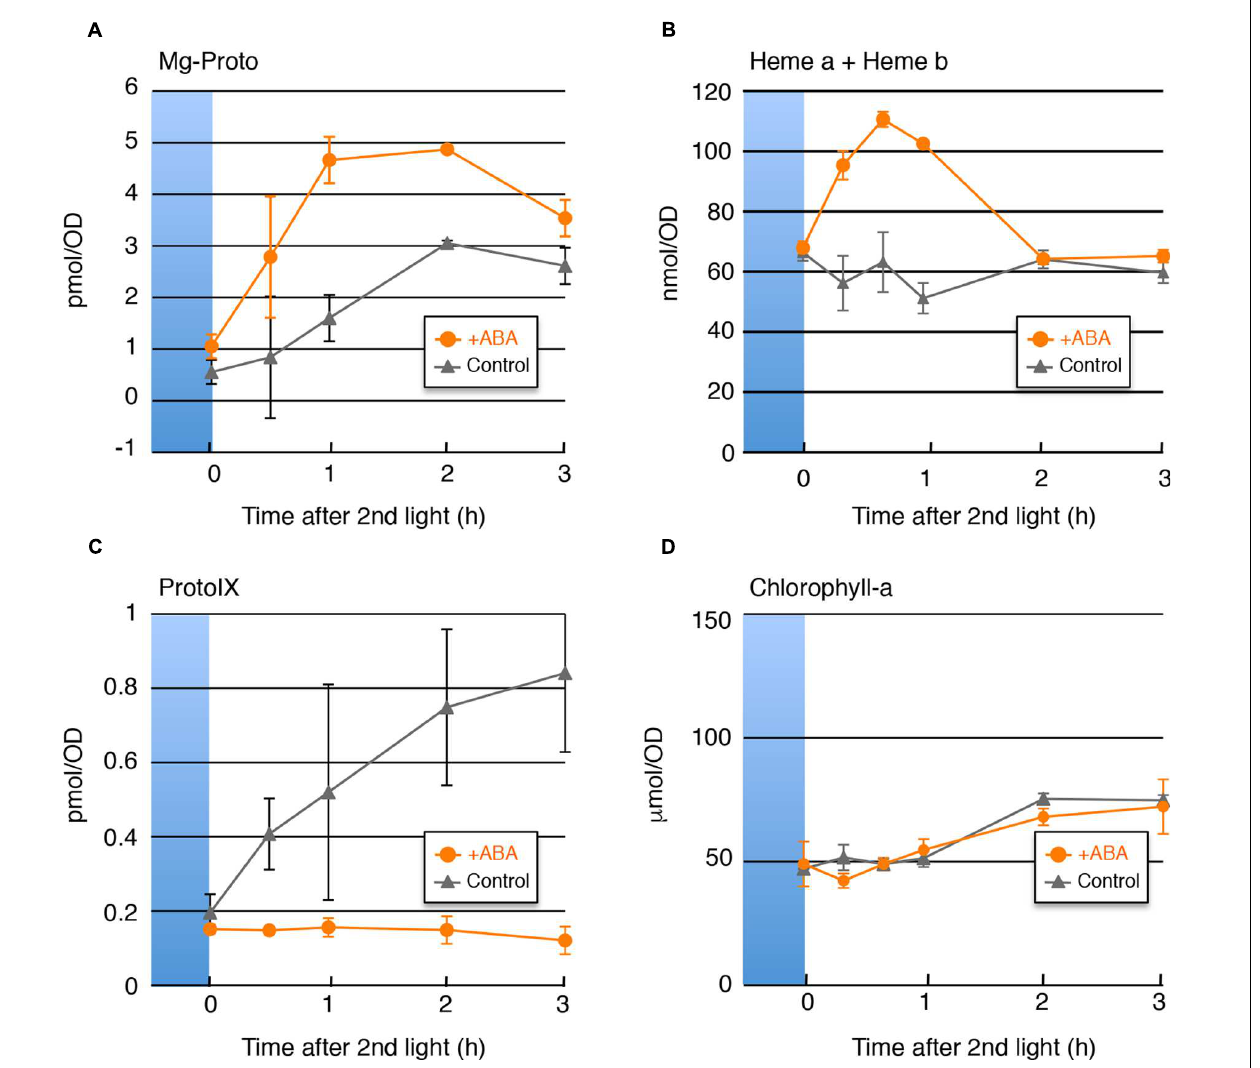
FIGURE 2 | Cellular Contents of Mg-ProtoIX, Heme, ProtoIX, and Chlorophyll-a. Changes in accumulation of (A) Mg-ProtoIX, (C) ProtoIX, and, (D) Chlorophyll-a in the absence (gray) or presence (orange) of ABA are shown. The sampled conditions were as in Figure 1 . (B) Changes in heme (heme a and heme b) accumulation (from Kobayashi et al., 2016) are also shown compared with previously obtained results. Each data point represents the average of three independent experiments ( n = 3 SD ). The x -axis indicates the amounts in 1 mL of culture medium (OD 750 = 1).